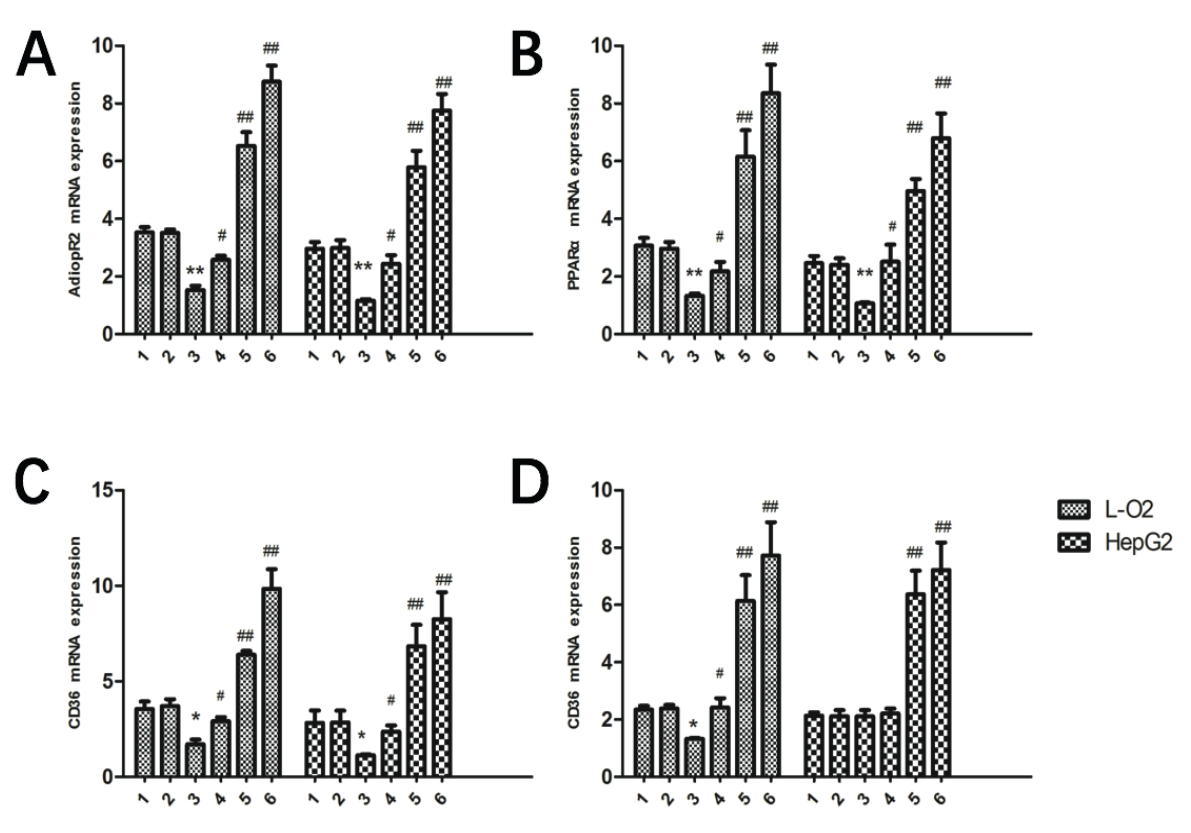
Figure 5: AdipoR2, PPARα, CD36, and acyl-CoA mRNA expression. 1: Normal group; 2: blank control group; 3: model group; 4: low dose group; 5: medium dose group; 6: high dose group. *p<0.05, **p<0.01vs the normal group. #p<0.05, ##p<0.01 vs the model